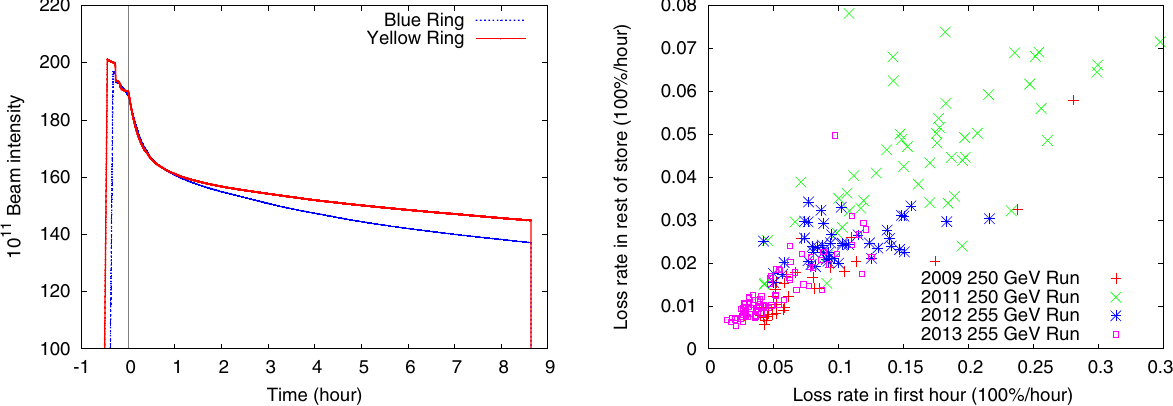
FIG. 3. Left: Evolutions of the beam intensities at store for Fill 16697. Right: Average particle loss rates in the first hour and in the rest of store for all the physics stores in the past 250 = 255 GeV